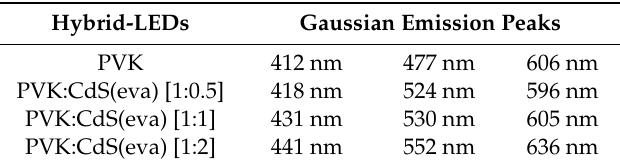
Figure 15. Gaussian deconvolution of electroluminescence spectra of PVK and hybrid LEDs. ( A ) Pristine PVK, ( B ) PVK:CdS(eva) [1:0.5], ( C ) PVK:CdS(eva). [1:1] and ( D ) PVK:CdS(eva) [1:2]. Table 3. Positions of the maximum of each emission peak for PVK–LED reference and the hybrid-LEDs doped with CdS nanoparticles. The wavelengths are obtained from the Gaussian deconvolution of electroluminescence